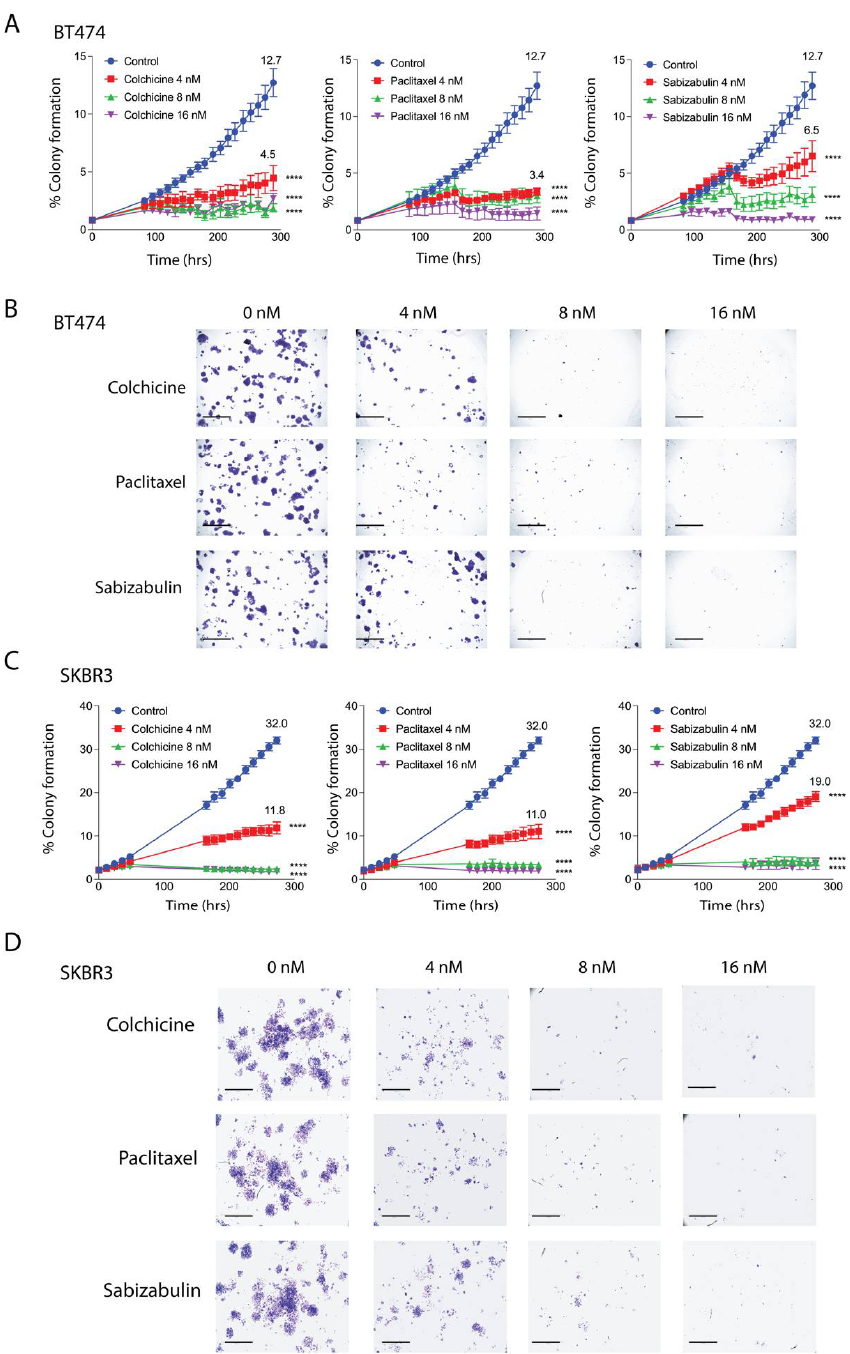
Figure 2. Effect of colchicine, paclitaxel and sabizabulin on colony formation in HER2+ breast cancer cell lines. The growth of colonies was measured for 12 days (288 hrs) in the presence of colchicine, paclitaxel or (4, 8, or 16 nM). ( A , B ) The area occupied by colonies over time was converted to a percentage (%) to enumerate colony formation. The mean percent colony formation is indicated at the study endpoint for control and 4 nM treated cells ( A , C ). All data represent the grand mean of two independent biological experiments, each assay was performed with n = 8 technical replicates/time point/cell line. Two-way ANOVA was performed followed by Dunnett’s multiple comparisons testing. All p -values are shown compared to the vehicle control group at the experimental endpoint; **** p < 0.0001. Representative pictures of stained colonies for BT474 ( C ) and SKBR3 ( D ) cells at assay endpoint are shown; scale bars, 50 µ